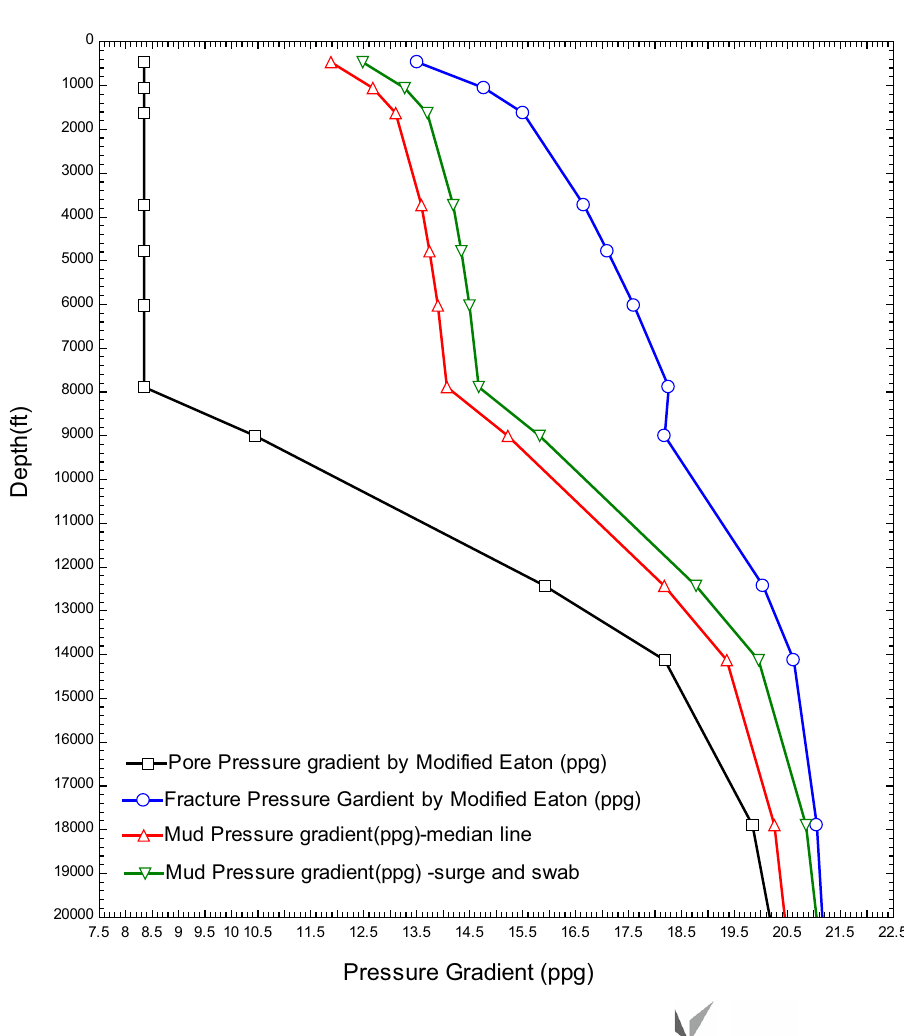
Fig. 19 Optimum mud weight on the top of the Tulamura anticline